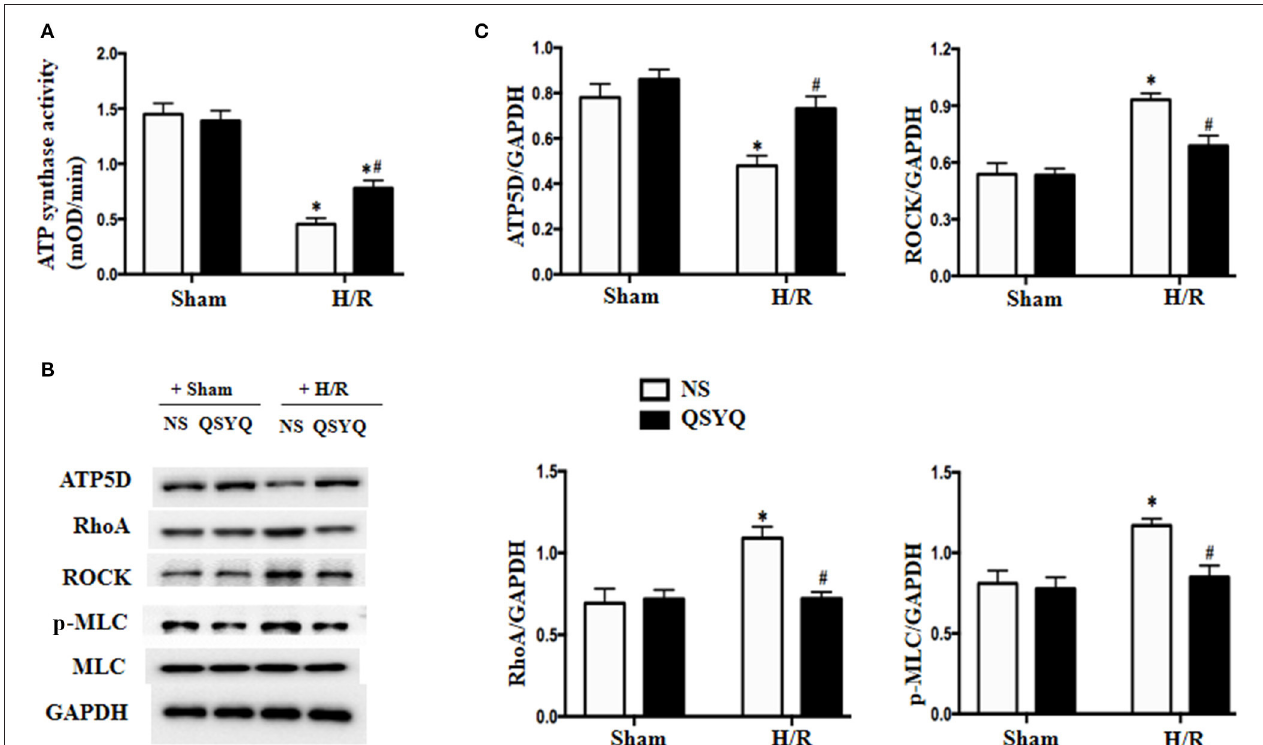
FIGURE 5 | Effect of QSYQ on the activity of ATP synthase and the expression of RhoA, ROCK, and p-MLC in HCMECs after H/R. (A) Quantitative measurement of complex I activity by ELISA in HCMECs. (B) Representative western blot bands of ATP5D, RhoA, ROCK, MLC, and p-MLC in HCMECs. GAPDH was used as a loading control. (C) Relative densitometric values of ATP5D, RhoA, ROCK, and p-MLC corrected for GAPDH. Data are expressed as means ± SEM ( n = 6). * p < 0.05 vs. NS + control group, # p < 0.05 vs. NS + H/R group. Statistical analysis was performed using two-way ANOVA followed by Bonferroni for multiple